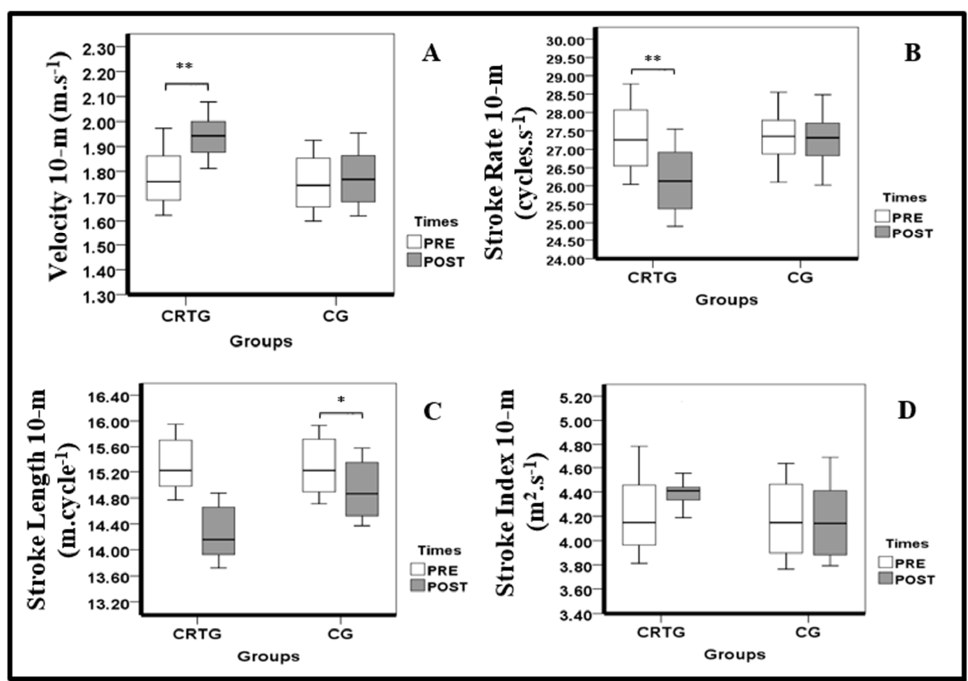
Figure 4. Box plots displaying the 25th and 75th percentiles, medians and whiskers extending from the minimal to maximal for the ( A ) velocity 10-m, ( B ) stroke rate 10-m, ( C ) stroke length 10-m and ( D ) stroke index 10-m in both groups (CRTG and CG) after 9 weeks of training (* p < 0.05; ** p < 0.01).